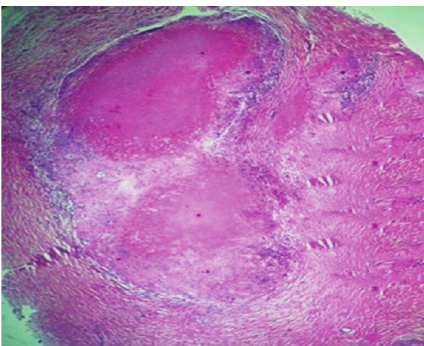
Figure 2: (Case 1): nerve biopsy, epithelioid granuloma with cen- tral caseous necrosis (H&E × 40).